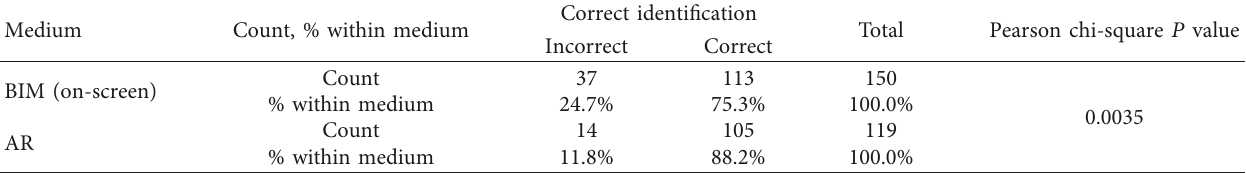
Table 8: Effect of medium on false-positive identification and corresponding chi-squared results.